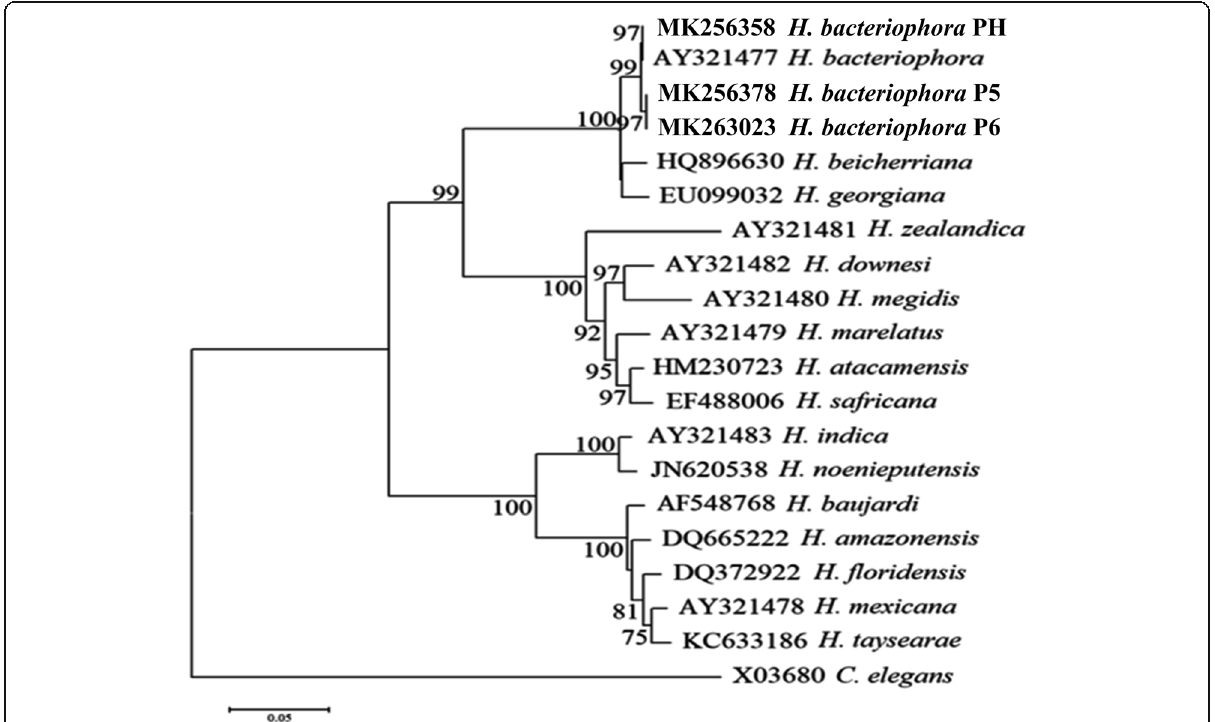
Fig. 1 Phylogenetic relationships of Heterorhabditis strains (P5, P6 and PH) with 16 Heterorhabditis spp. based on ITS rDNA sequences. Caenorhabditis elegans (X03680) was used as the out-group taxa. The percentage of replicate trees in which the associated taxa clustered together in the bootstrap test (10,000 replicates) is shown next to the